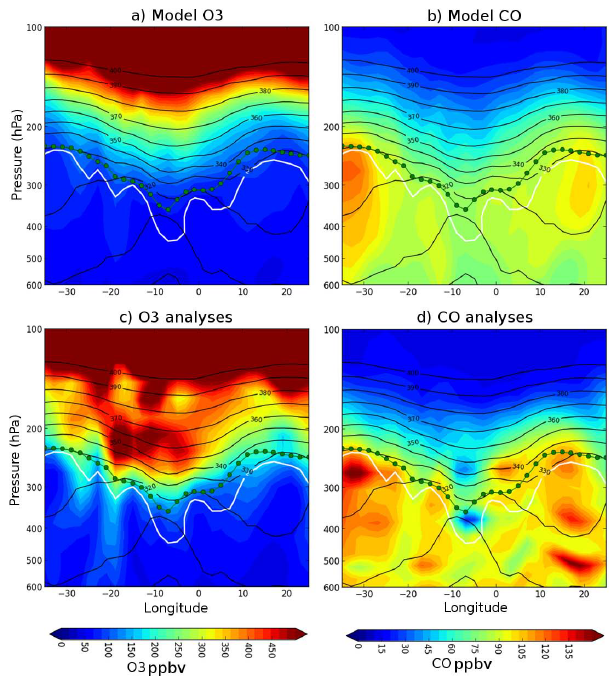
Fig. 2. Zonal cross sections at 59 ◦ N between 40 ◦ W and 40 ◦ E lon- gitude and between 600 and 100hPa in the vertical for model O 3 (a) , model CO (b) , O 3 analyses (c) and CO analyses (d) . The white line corresponds to the 2PVU contour. The black lines correspond to the 300 to 400K isentropic contours by 10K intervals. The line with green circles corresponds to the thermal tropopause. Panels are for 15 August 2007 at